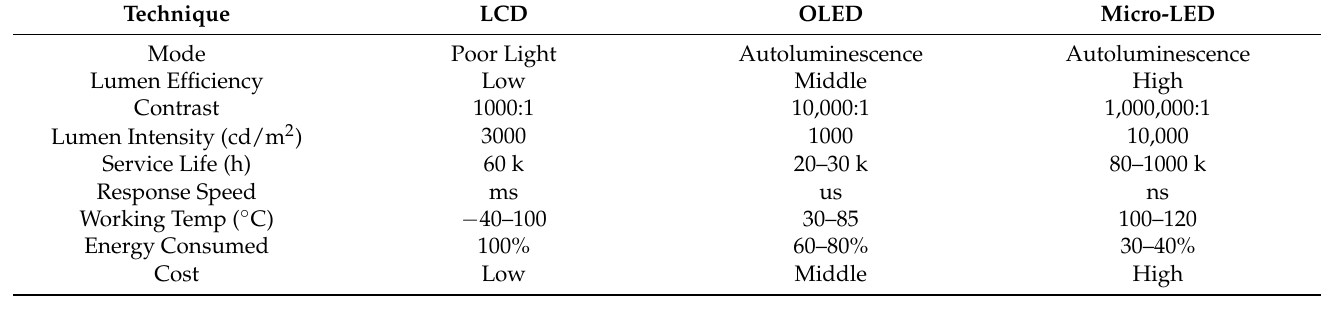
Table 1. Comparison of performance parameters of LCD, OLED and micro-LED display devices.